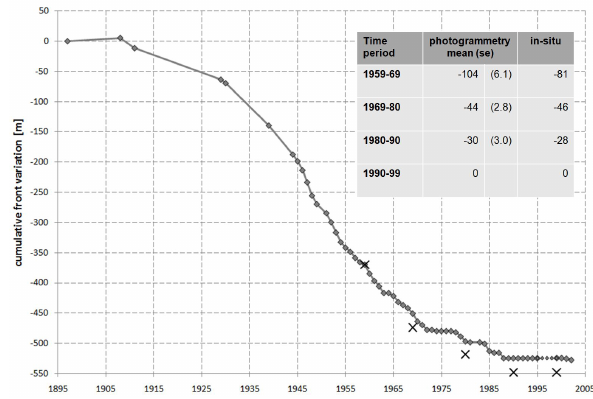
Fig. 5. Length change of Storglaci¨aren 1897–2002. The cumu- lative front variations are shown, based on the in-situ observations (grey line and diamonds) and as derived from the orthophotos (black crosses). All values are given in meters. Note that in the figure, the in-situ value of 1959 was used as a common reference